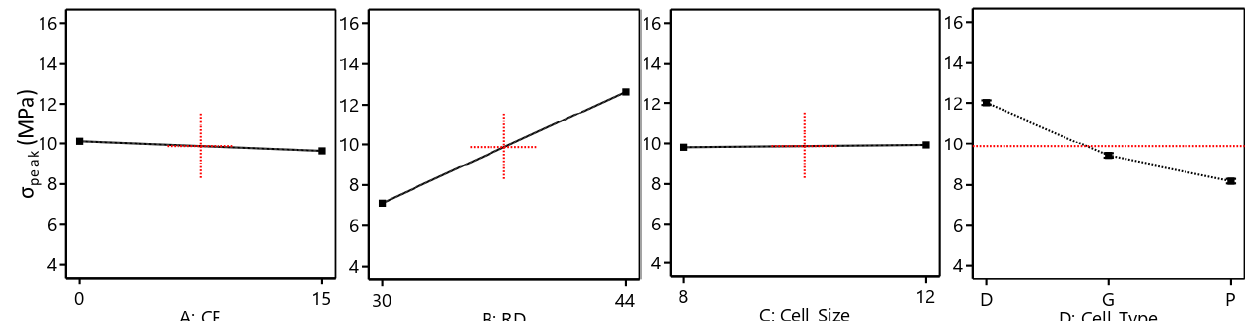
Figure 11. Influence of the main factors on the σ peak .